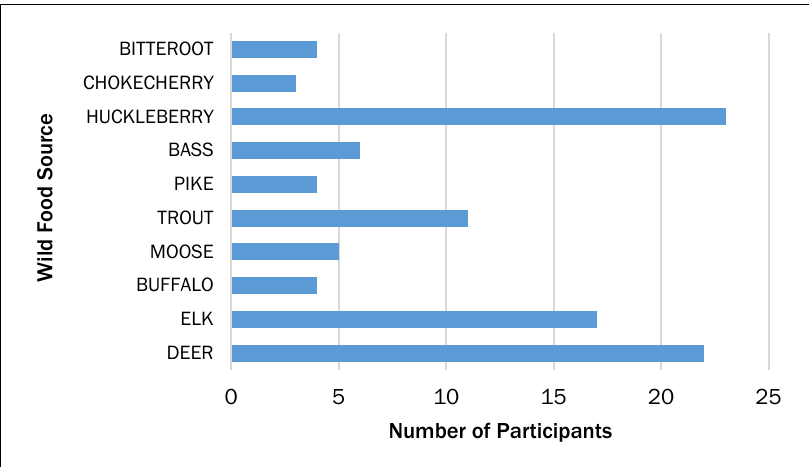
Figure 1. Commonly Reported Wild Foods Consumed By Participants